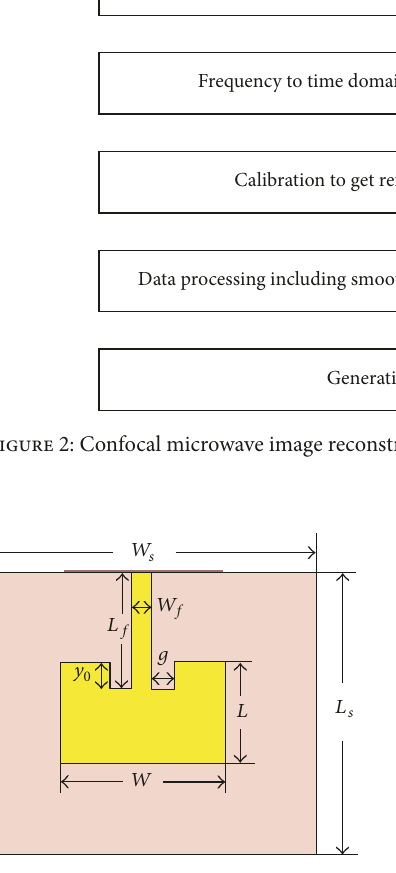
Figure 3: Schematic diagram of patch antenna without EBG